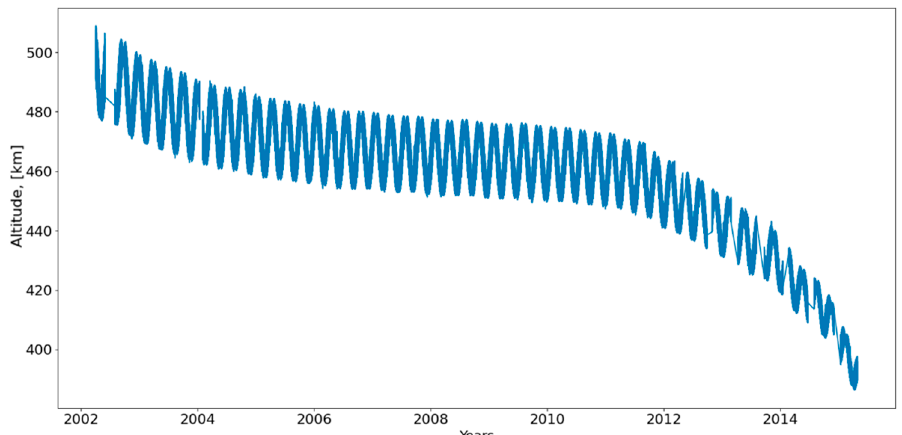
Figure 1. Evolution of the orbital altitude during the GRACE mission.